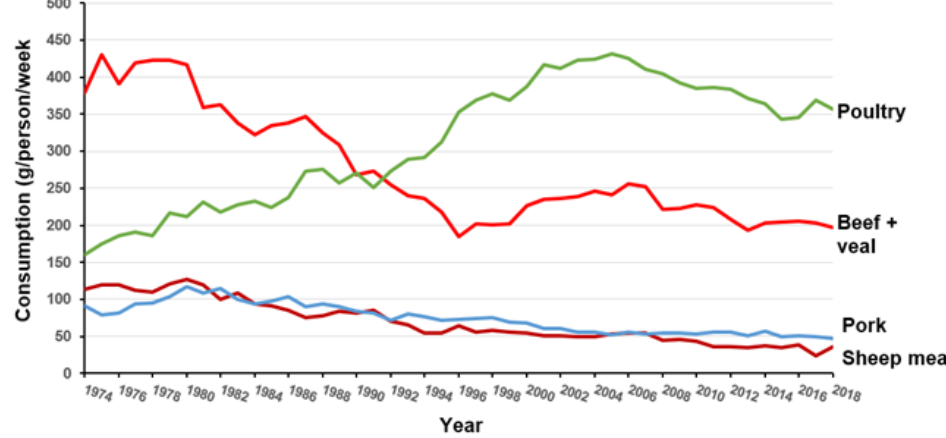
Figure 2. Changes in meat types consumed in the UK 1974–2018 (from DEFRA [25]). It is clear that red meat can be an important source of dietary iron but traditional dietary habits or reductions in habitual red meat consumption have led to sub-optimal iron intake with the attendant increase in the risk of IDA. The increased reliance on plant-based sources of dietary iron indicates the need for more attention to the concentration and bioavailability of this iron. It also suggests that maybe the use of red meat as an iron source should be targeted at children and young